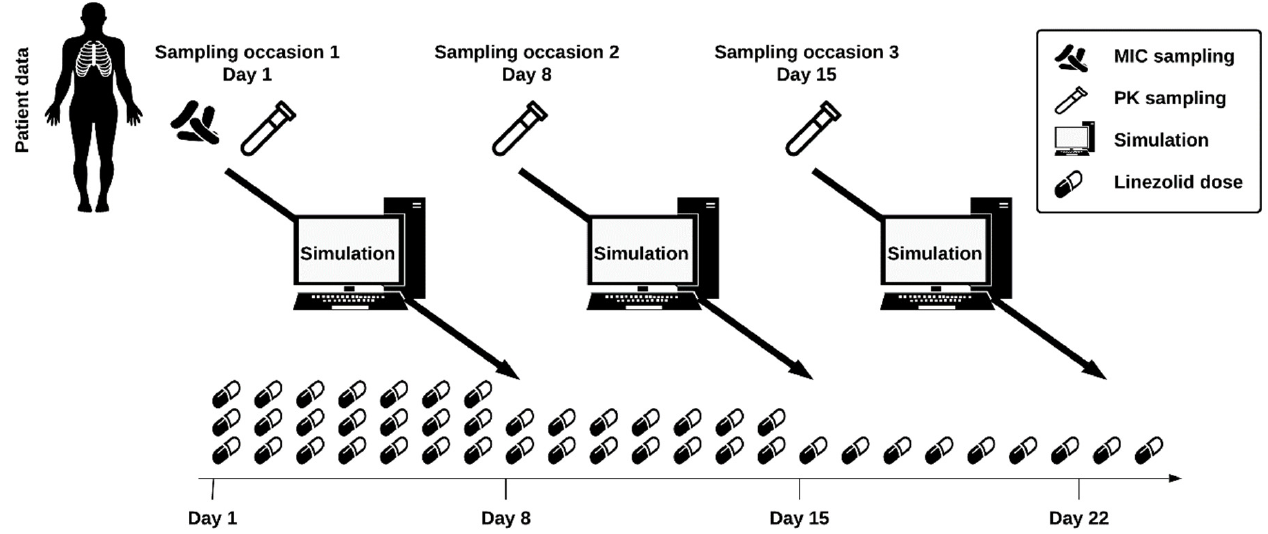
Figure 3. Model-informed precision dosing workflow. MIC determination is performed on day 1 of treatment and PK sampling on days 1, 8, and 15. A Bayesian forecast is then performed using the population PK model, patient characteristics, and individual linezolid plasma concentrations. Taking efficacy and safety into account, the dose is adjusted one week after PK sampling. MIC, minimal inhibitory concentration; PK, pharmacokinetics.